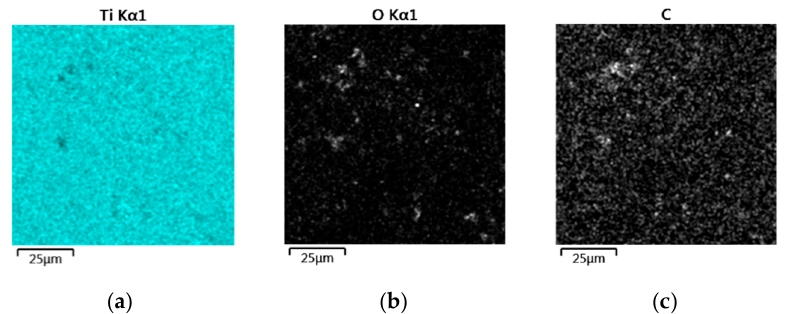
Figure 1. Micrograph of the surface ( a ) and mapping the structure ( b ) of the initial fraction of titanium hydride by chemical composition: 1, 2—zones of mapping of chemical elements.